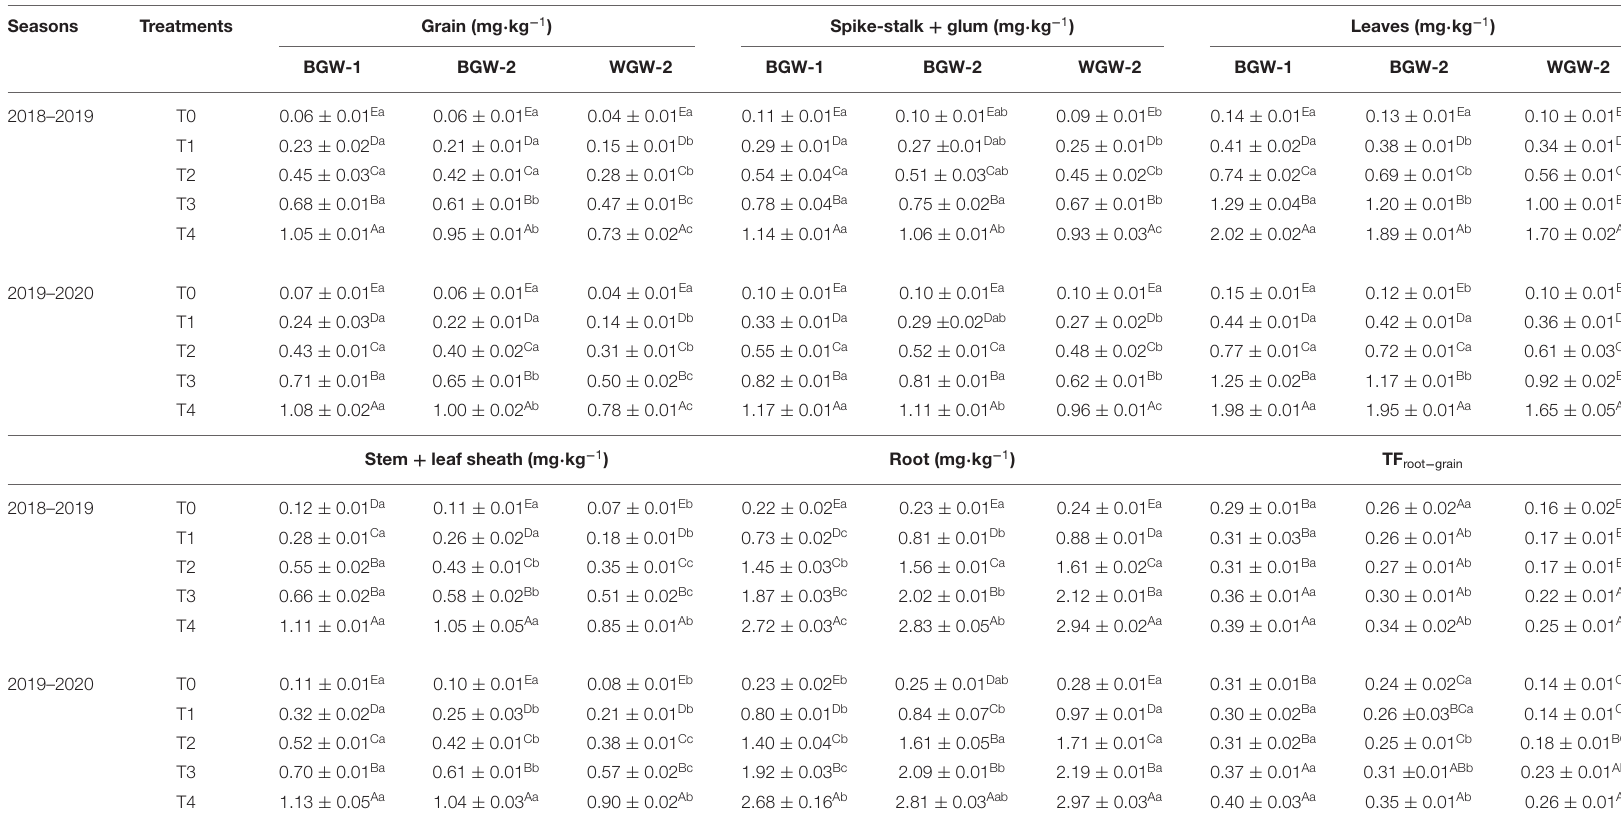
Different capital letters in the same column indicate a significant difference at α = 0.01. Different lowercase letters in the same row indicate a significant difference at α = 0.05. T0, no Se fertilizer; T1, 1,080 g · ha − 1 pure Se; T2, 2,160 g · ha − 1 pure Se; T3, 3,240 g · ha − 1 pure Se; T4, 4,320 g · ha − 1 pure Se; BGW-1, black-grained wheat genotype Xihei 88; BGW-2, black-grained wheat genotype Heidali; WGW-2, white-grained wheat cultivar Pubing